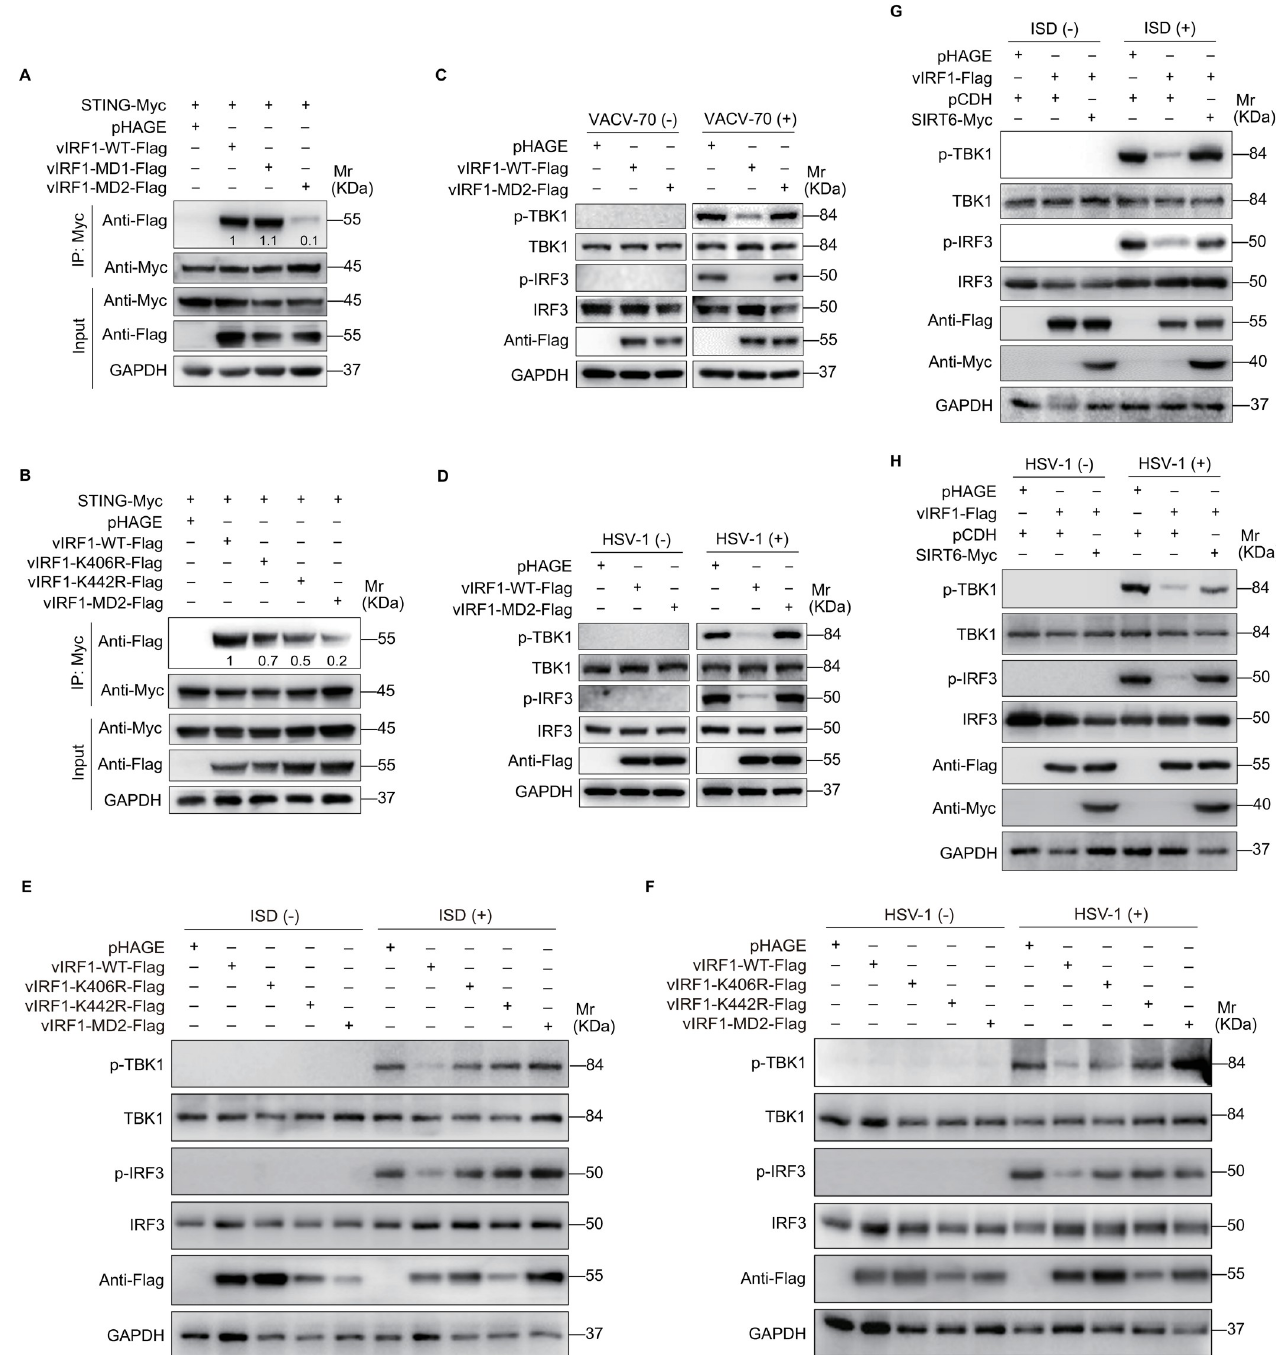
Fig 6. vIRF1 propionylation blocks the STING DNA sensing pathway. (A). HEK293T cells with STING overexpression ( STING-Myc ) were transfected with the wild type vIRF1 ( vIRF1-WT-Flag ), DBD-mutated vIRF1 ( vIRF1-MD1-Flag ), IAD-mutated vIRF1 ( vIRF1-MD2-Flag ), or its control ( pHAGE ). Cells were subjected to the anti-Myc immunoprecipitation and analyzed by Western blot using anti-Flag antibody. The relative intensities of the bands were quantified and normalized to Myc-tagged STING. The values are labeled under the protein bands. The relative values of proteins in the vIRF1-WT-Flag group were set as “1” for comparison. (B). HEK293T cells with STING overexpression ( STING-Myc ) were transfected with the wild type vIRF1 ( vIRF1-WT-Flag ), the mutant vIRF1 ( vIRF1-K406R-Flag , vIRF1-K442R-Flag , vIRF1-MD2-Flag ), or its control ( pHAGE ). Cells were subjected to the anti-Myc immunoprecipitation and analyzed by Western blot using anti-Flag antibody. The relative intensities of the bands were quantified as in ( A ). (C-D). EA.hy926 cells with the wild type vIRF1 ( vIRF1-WT-Flag ), IAD-mutated vIRF1 ( vIRF1-MD2-Flag ), or its control ( pHAGE ) overexpression were transfected with VACV-70 ( C ) or infected with HSV-1 ( D ). The phosphorylated TBK1 ( p-TBK1 ), TBK1 ( TBK1 ), phosphorylated IRF3 ( p-IRF3 ) and IRF3 ( IRF3 ) were examined by Western blot. (E-F).